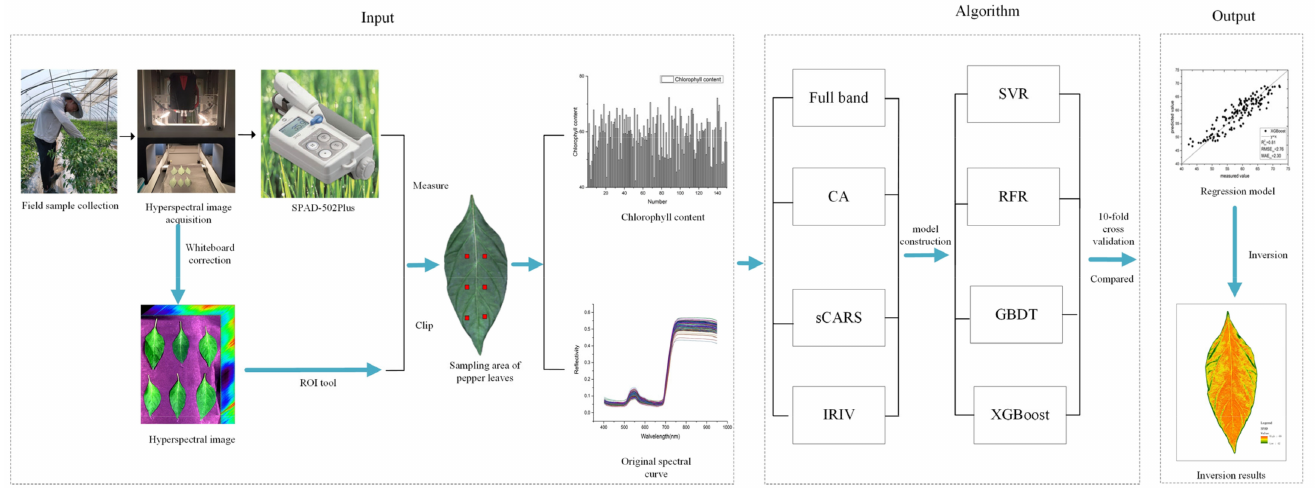
Figure 5. Technical